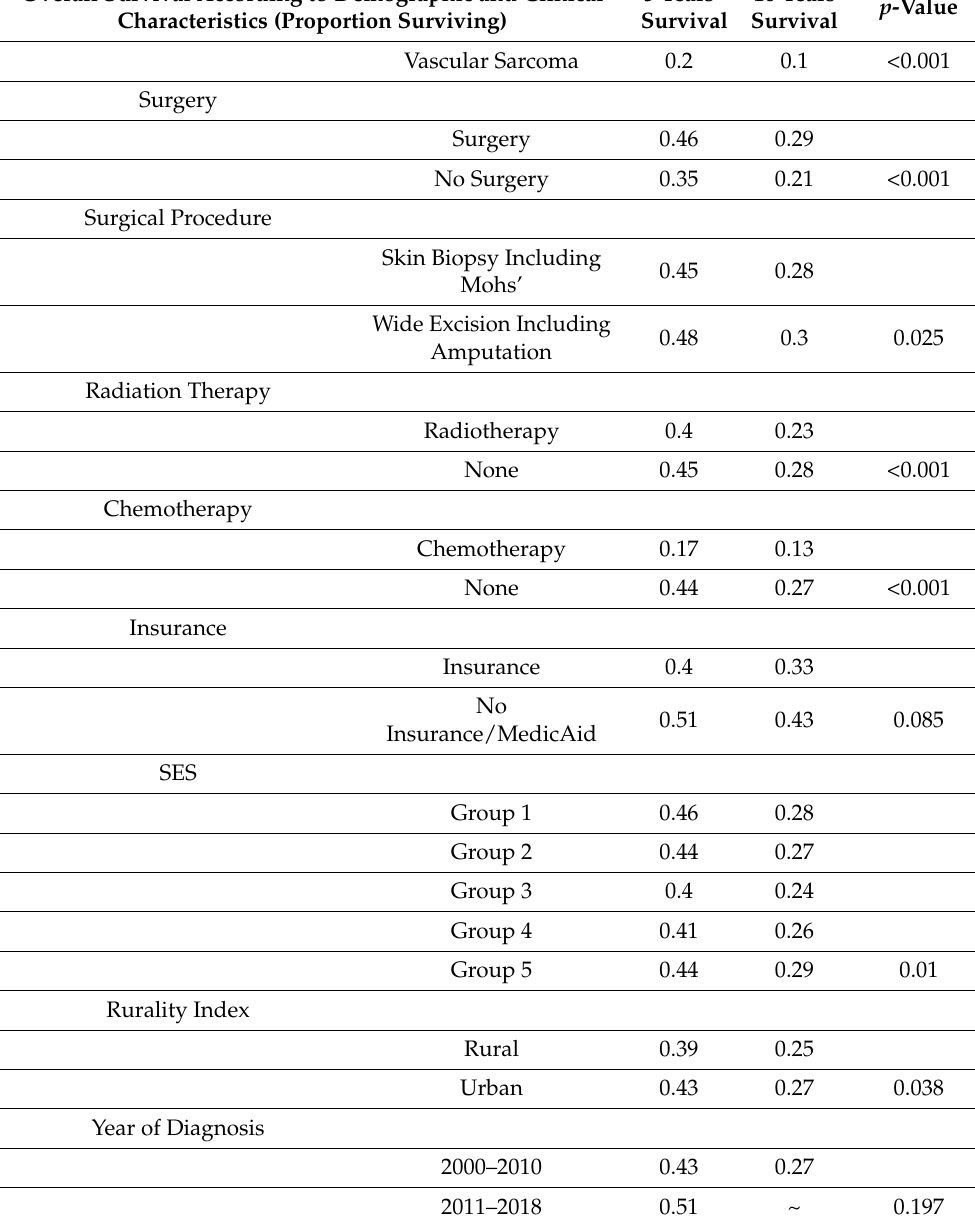
Table 2. Cont. Overall Survival According to Demographic and Clinical Characteristics (Proportion